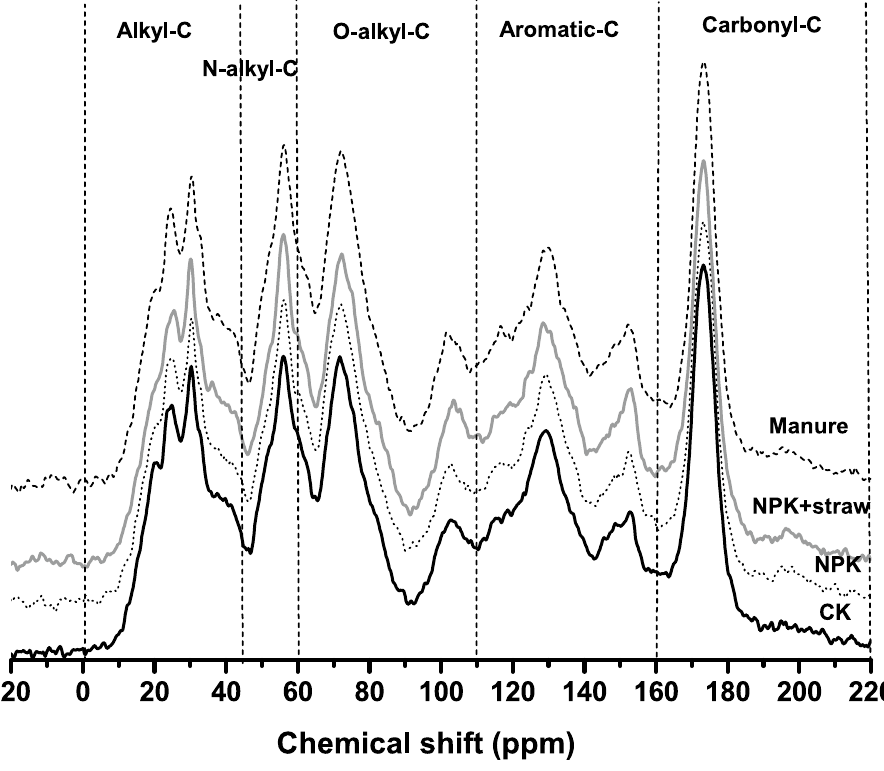
Figure 2. CP /MAS 13 C-NMR spectrum characteristics of humic acid in red soil under four fertilization treatments.